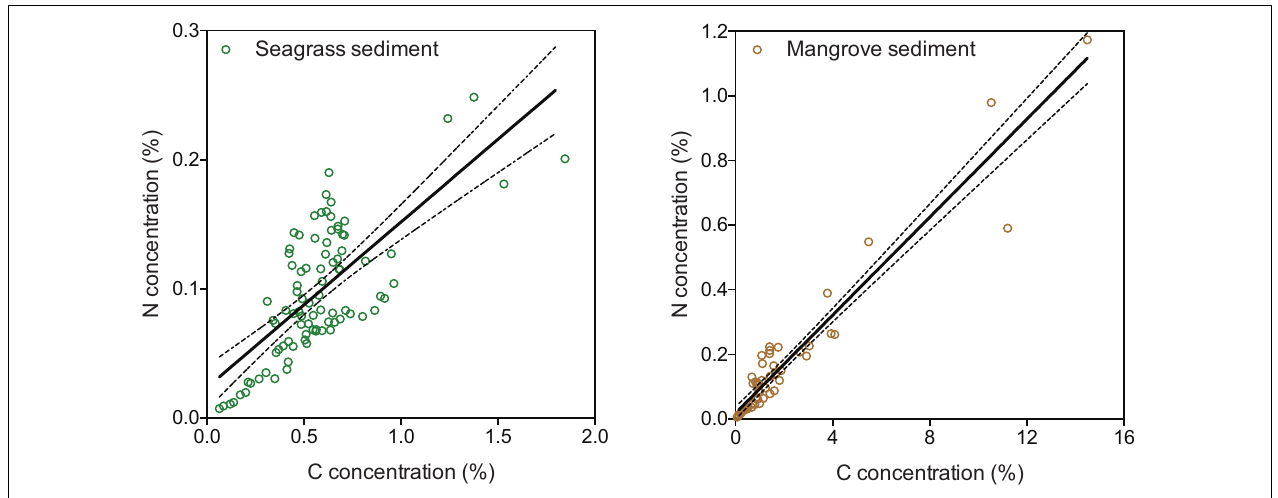
FIGURE 3 | Relationships between N and C org concentrations in seagrass (left) and mangrove (right) sediments, showing the fitted regression lines (solid lines) and the 95% c.i. (dashed lines).